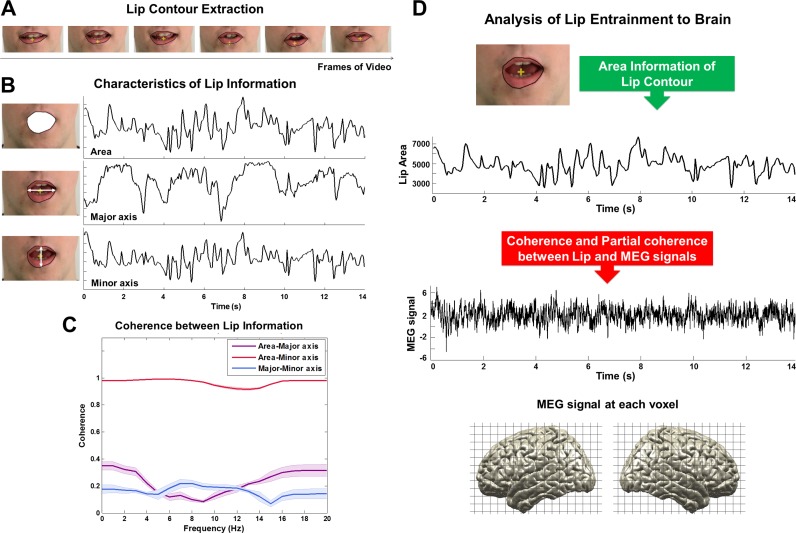
A schematic figure for the analysis of coupling between lip movements and brain activity.We extracted lip movement signals by automatically computing for each video frame the lip contour using our in-house MATLAB script (A). The contour was converted into the three quantities area, major axis and minor axis (B). We then computed the coherence between these measures (C). Area and minor axis (representing vertical lip movement) information have almost identical information approaching 1.0 in coherence value (red line; mean ± s.e.m.). However, major axis information representing horizontal lip movement only does not show similar pattern with either area or minor axis (purple and blue lines; mean ± s.e.m.). Since area information represents both horizontal and vertical lip movement, we used this information for further analysis. We then computed coherence between lip area signals and MEG signals at each voxel for each frequency band and for all four experimental conditions (D; see Materials and methods).